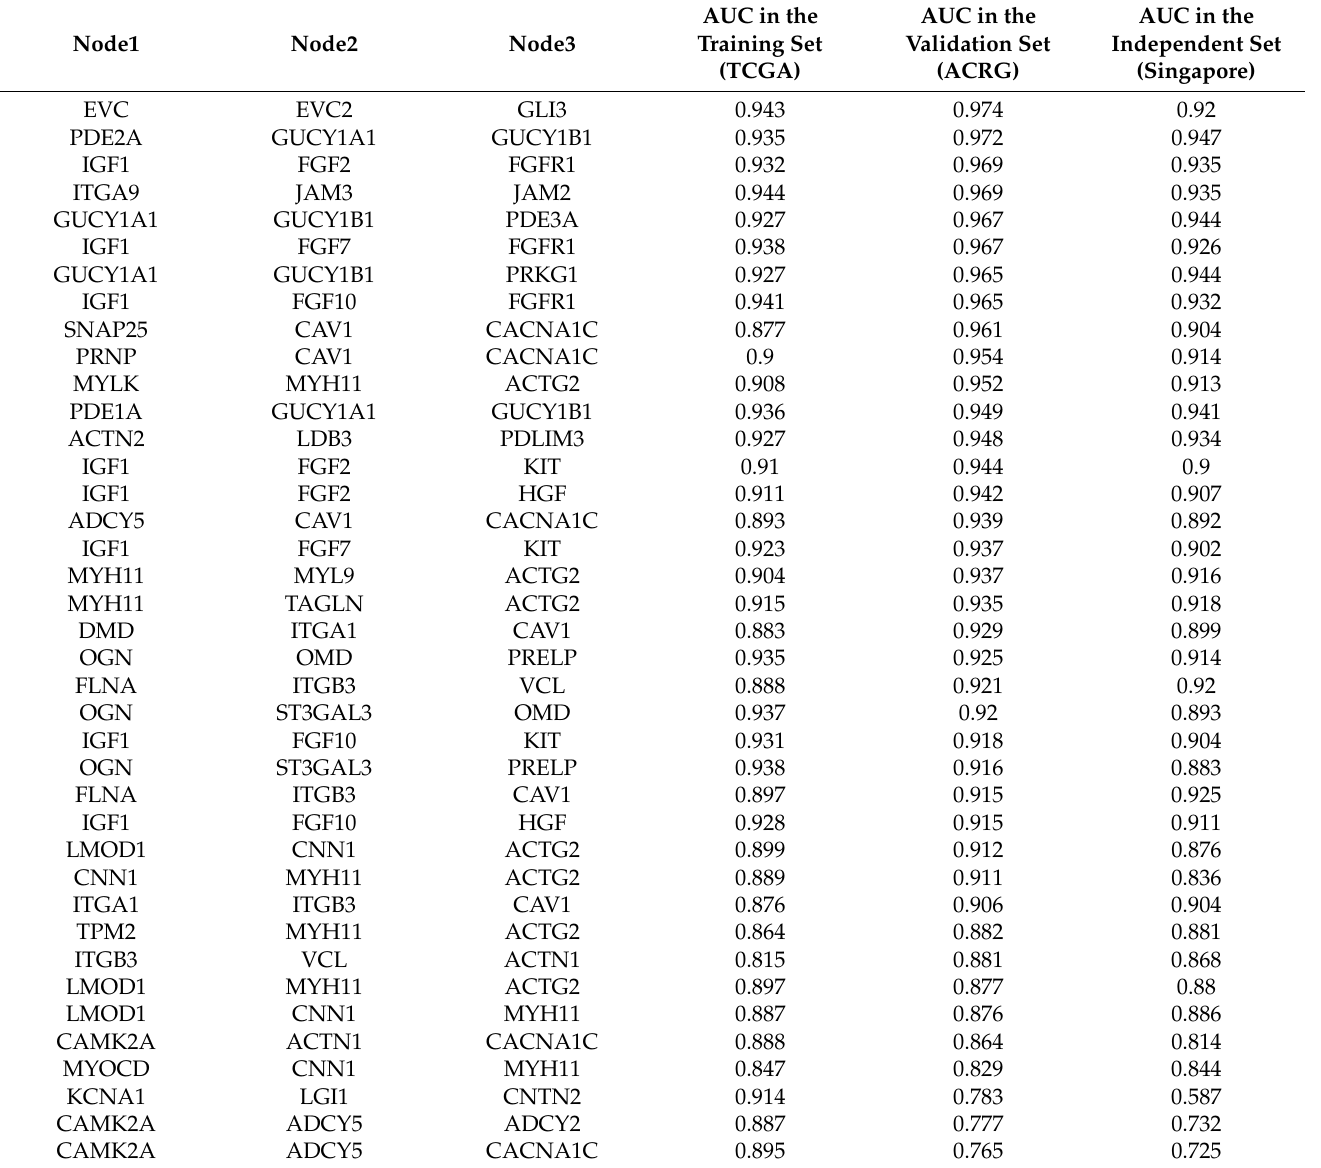
Table 3. The diagnostic capacity of the logistic regression models for distinguishing between the EMT subtype and the other subtypes for the 39 top